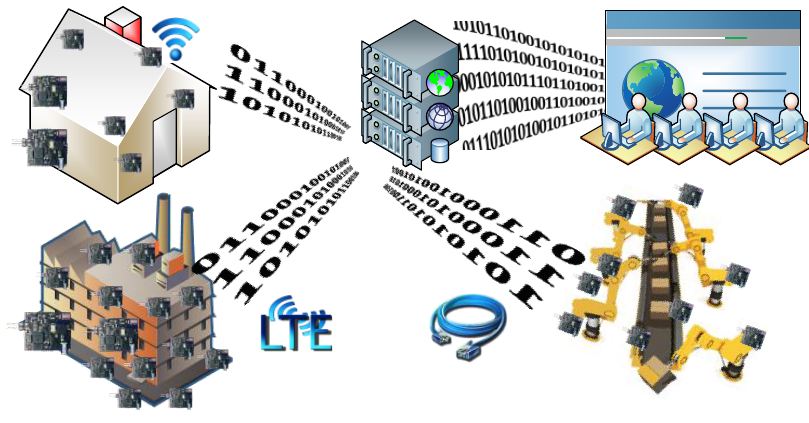
Figure 11. Wireless sensor network (WSN) usage in different